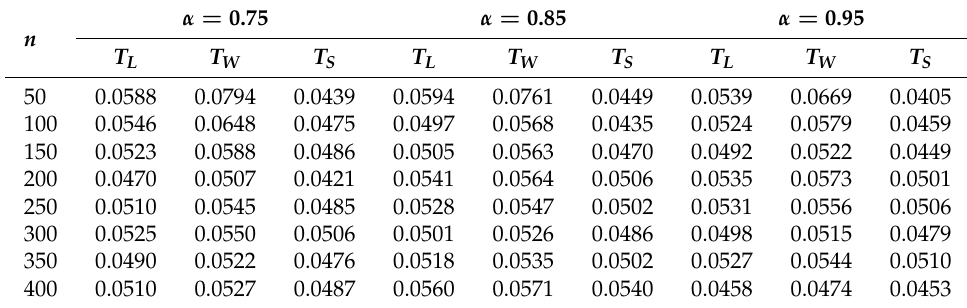
Table 5. The empirical levels of statistics ( T L , T W , T S ) for Case (B2).